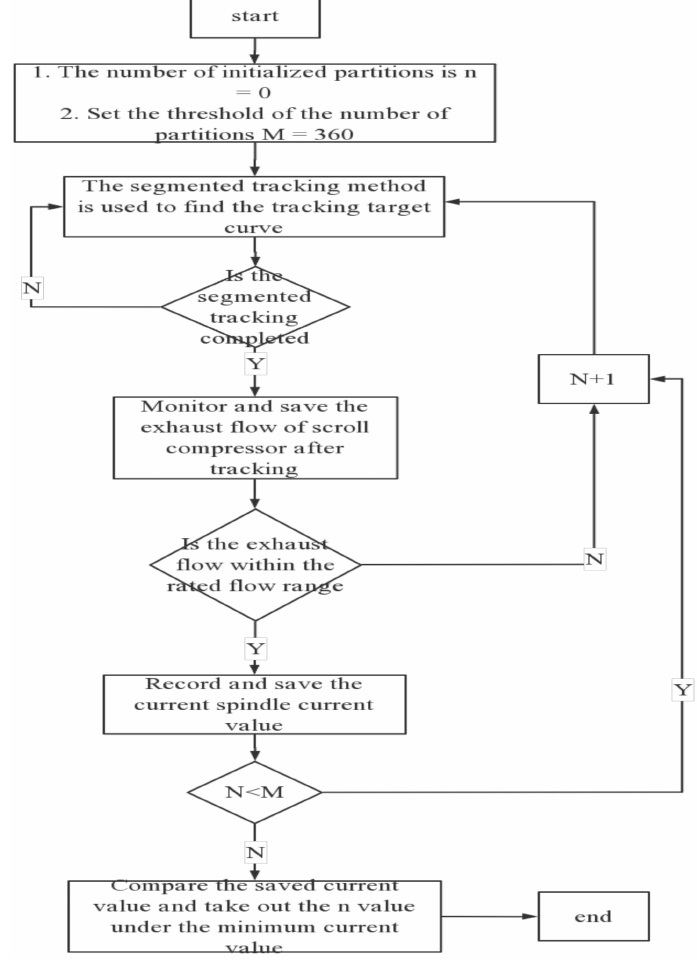
Figure 12. Flow chart of automatic optimization algorithm for the partition number of probes.